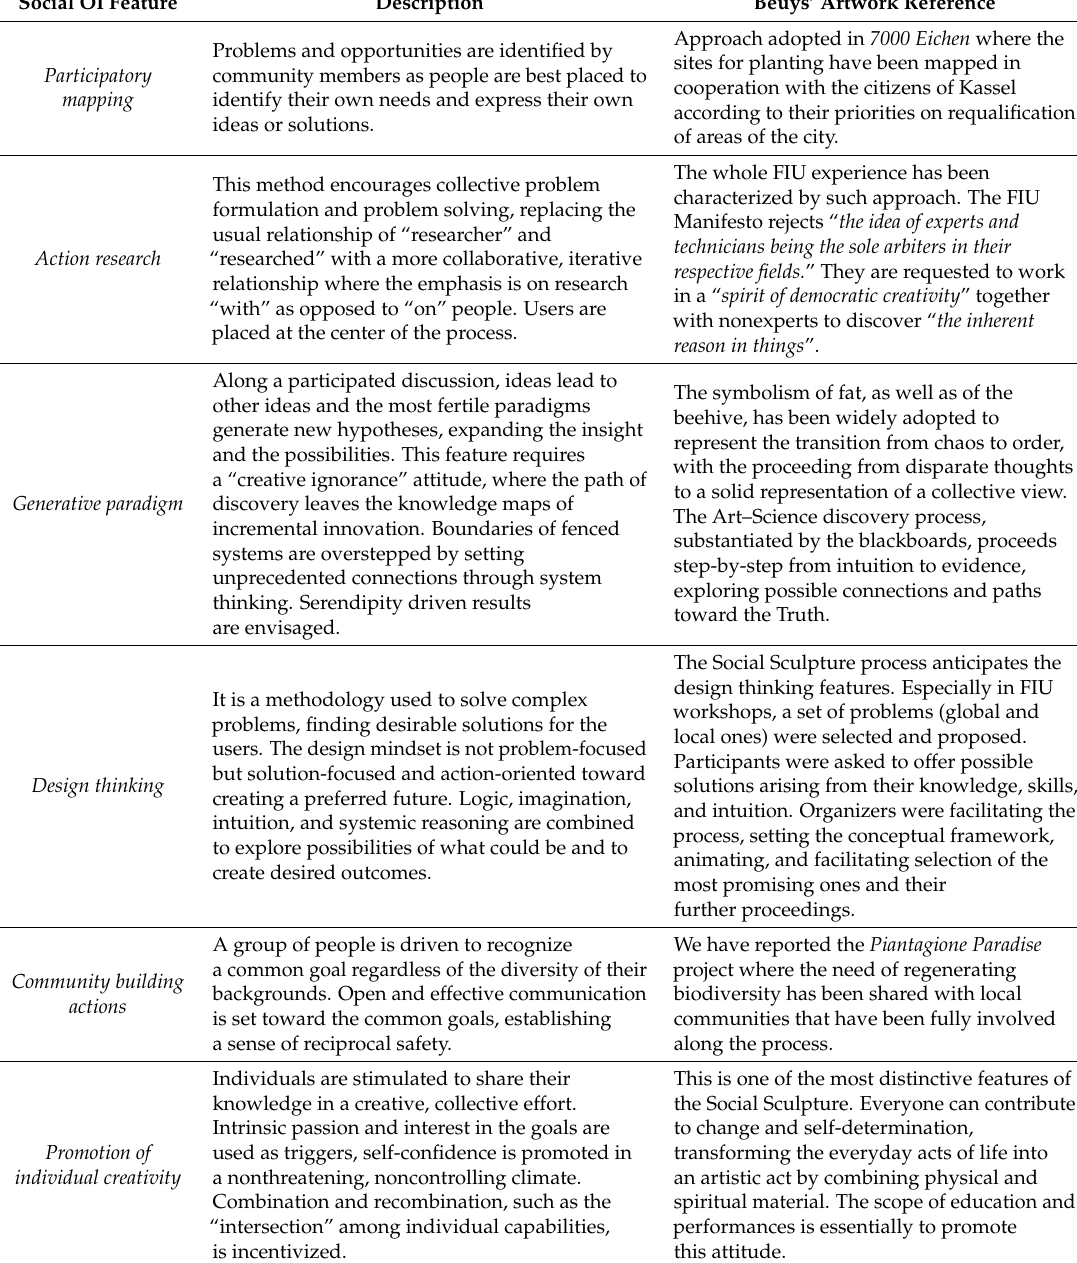
Table 1. Key open social innovation features anticipated by Beuys’